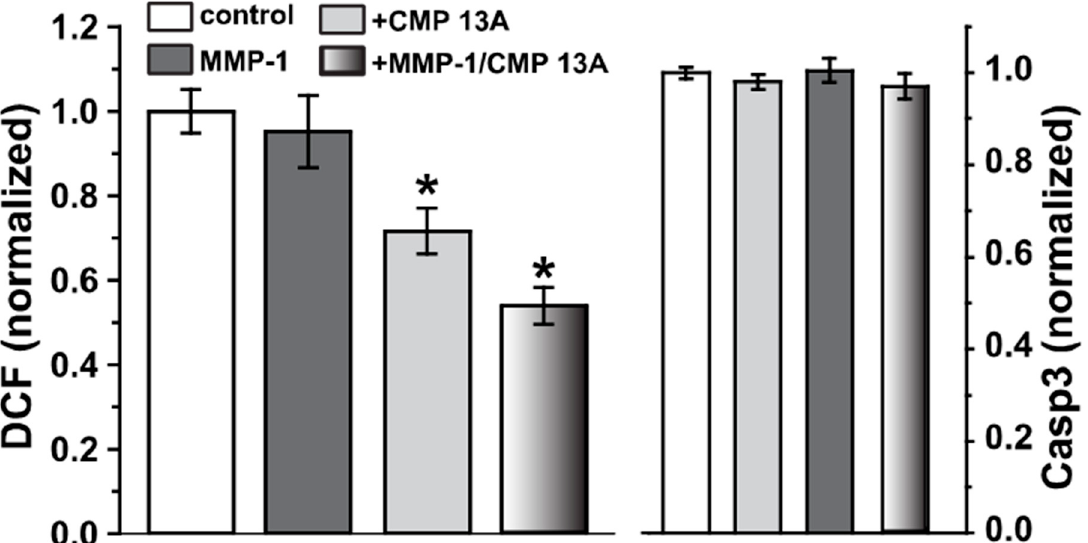
Figure 6. CMP treatment reduces ARPE-19 oxidative stress. Left: fluorescent signal from dichlorodi- hydrofluorescein (DCF) treated ARPE-19 cells as a measure of reactive oxygen species (ROS). Ap- plication of CMP 13A (200 µM) to either intact collagen or collagen digested by MMP-1 (120 nM) significantly reduced levels of ROS compared to both intact control and untreated MMP-1 digested collagen (*, p ≤ 0.04); the two CMP 13A conditions did not differ ( p = 0.14). Right: no condition increased ARPE-19 apoptosis compared to control, as assessed by caspase-3 (Casp3) activity ( p = 0.30). For each measurement, n ≥ 15.